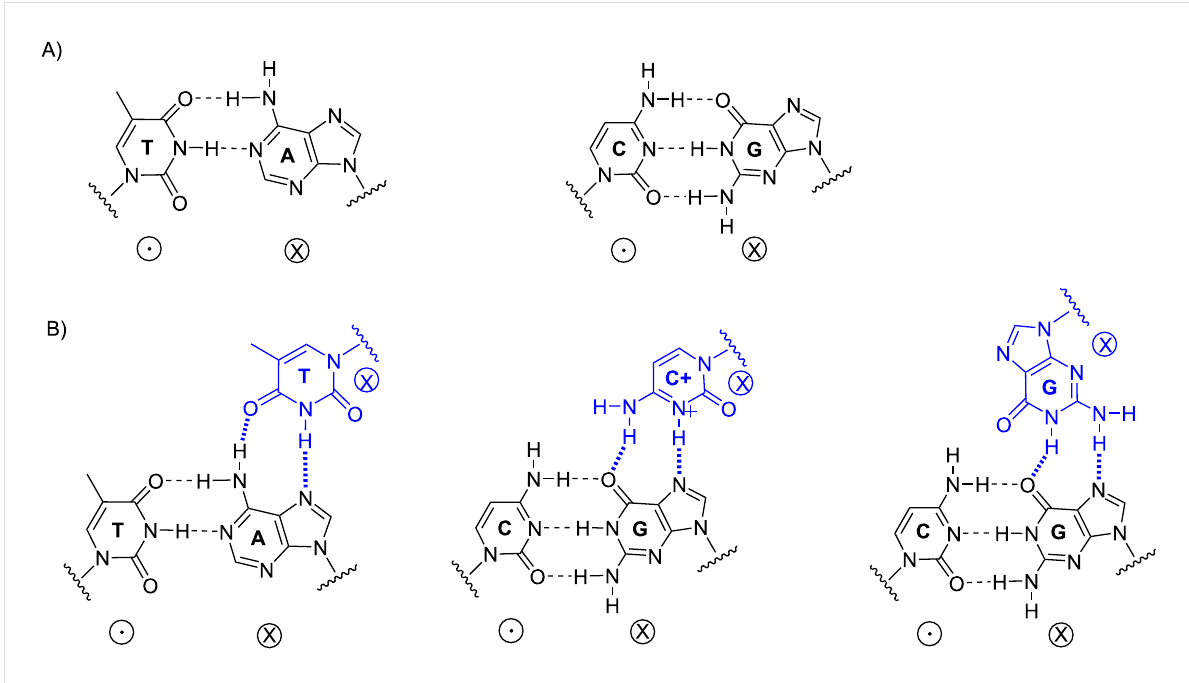
Figure 1: Illustration of H-bonding in a DNA duplex and a parallel triplex. A) Depiction of Watson–Crick base-paring (left: T-A and right: C-G); B) parallel triple helices: pyrimidine-rich third strand interactions are stabilised by Hoogsteen hydrogen bonds (the duplex is in black, TFO is in blue, Watson–Crick base-paring is shown with dashed bonds, and Hoogsteen base-paring is shown with hashed bonds). The relative orientation of phos- phodiester backbones is indicated by the symbols " " and "